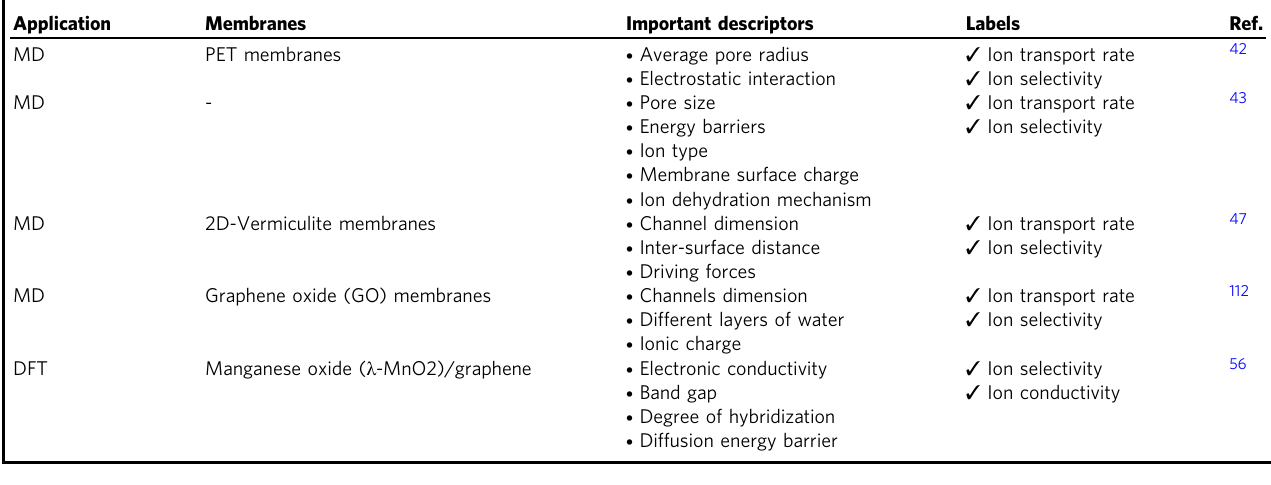
Table 2 Different descriptors for energy-based AI models.